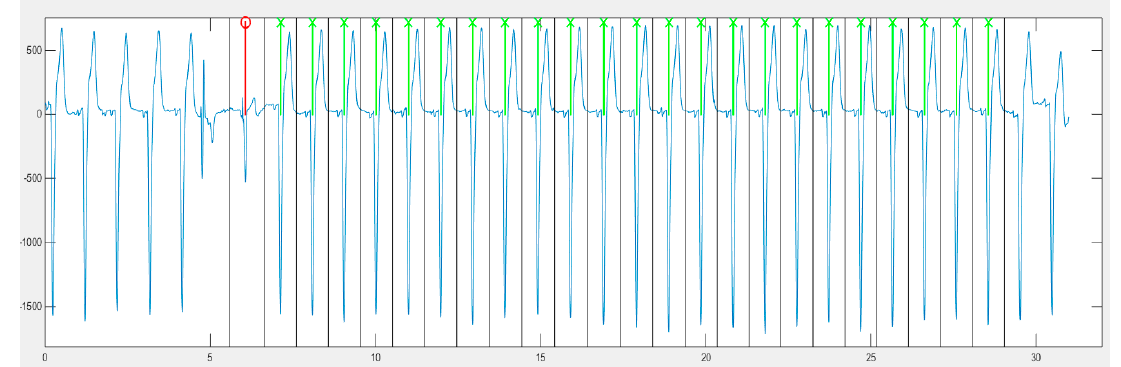
Figure 4. Example of the signal with included (green) and excluded (red)